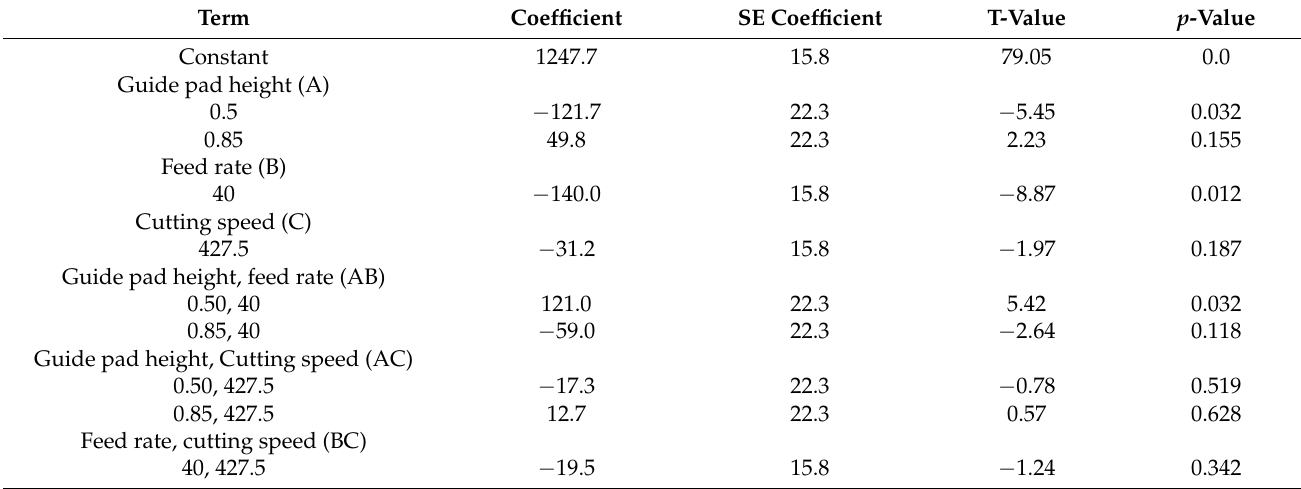
Table 7. Estimated effects and coefficients for the maximum temperature in the drill head.